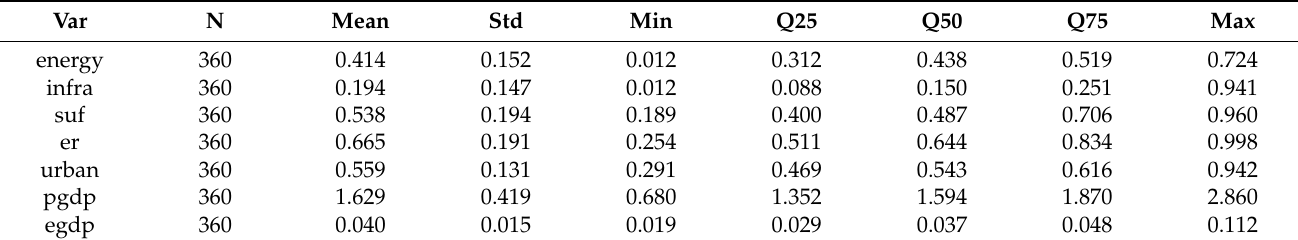
Table 3. Descriptive statistics of variables.